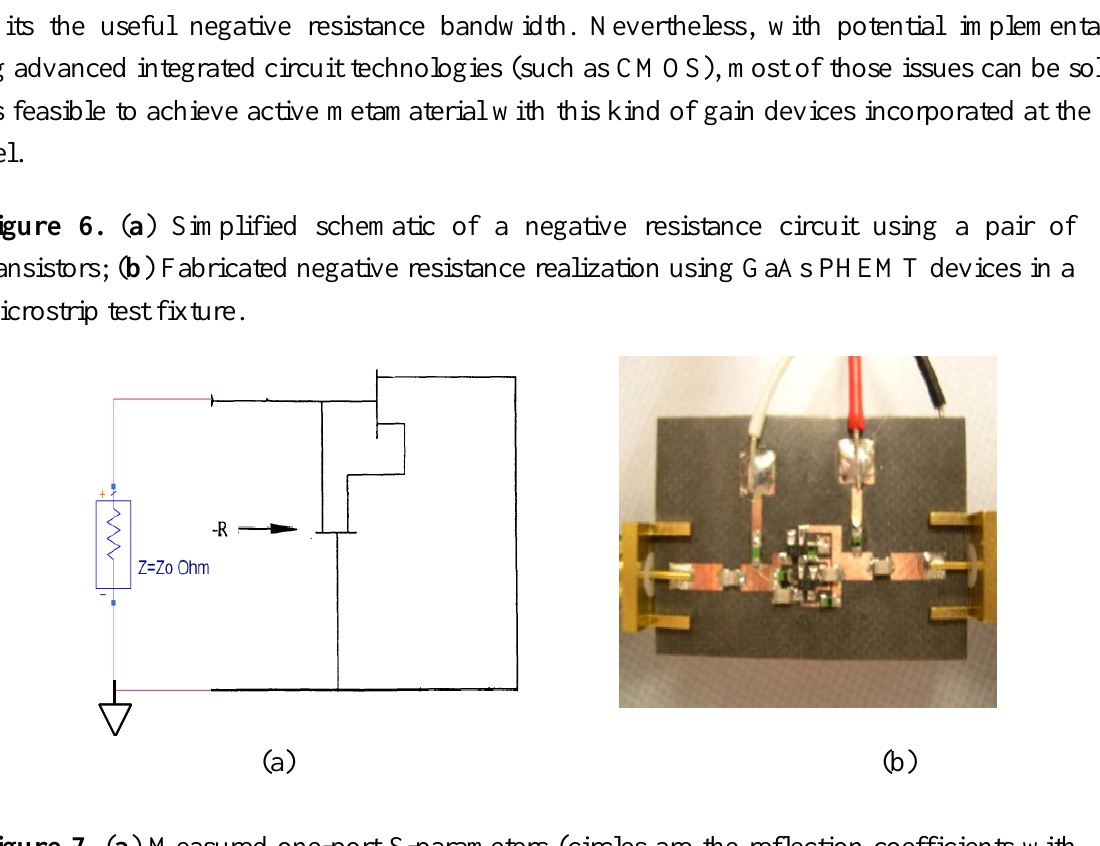
Figure 7. ( a ) Measured one-port S-parameters (circles are the reflection coefficients with port 2 grounded; and squares are the reflection coefficients with port 1 grounded) of the negative resistance circuit using a pair of transistors; ( b ) Calculated equivalent resistances from the measured one-port S-parameters (circles are the resistance seen at port 1 with port 2 grounded; and squares are the resistance seen at port 2 with port 1